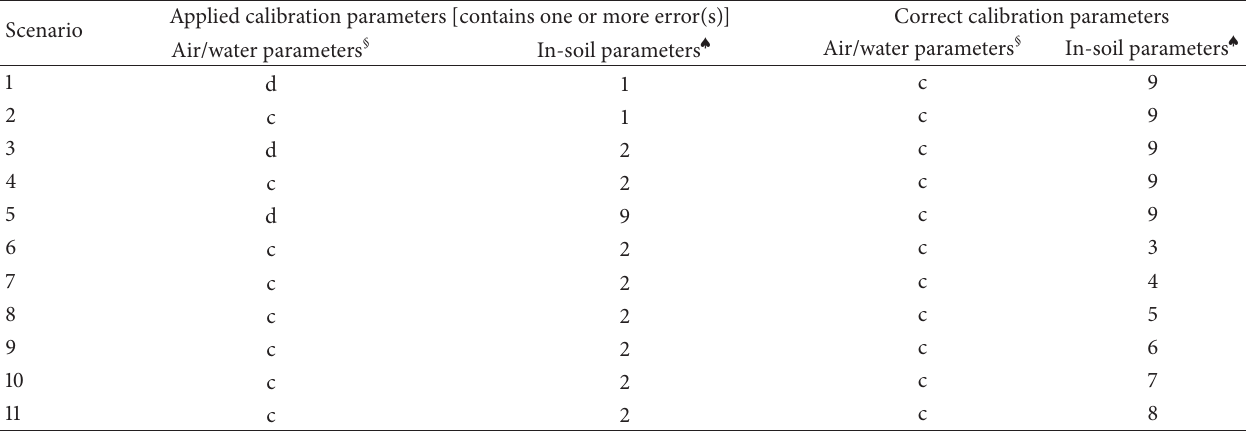
Table 4: The studied scenarios to compare correct versus incorrect calibration parameters.